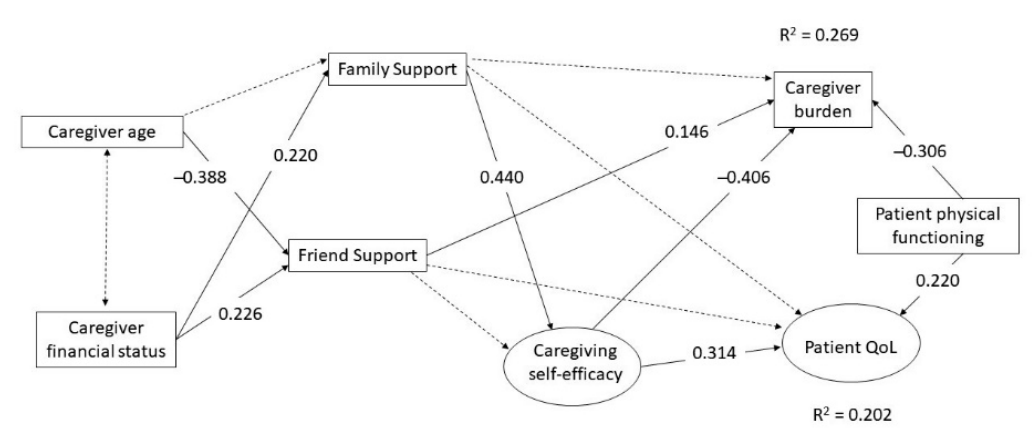
Figure 1. Hypothesized model linking source of social support, caregiving self-efficacy, caregiver burden, and patient’s quality of life. Insignificant paths are in dashed line and were eliminated in the final model.